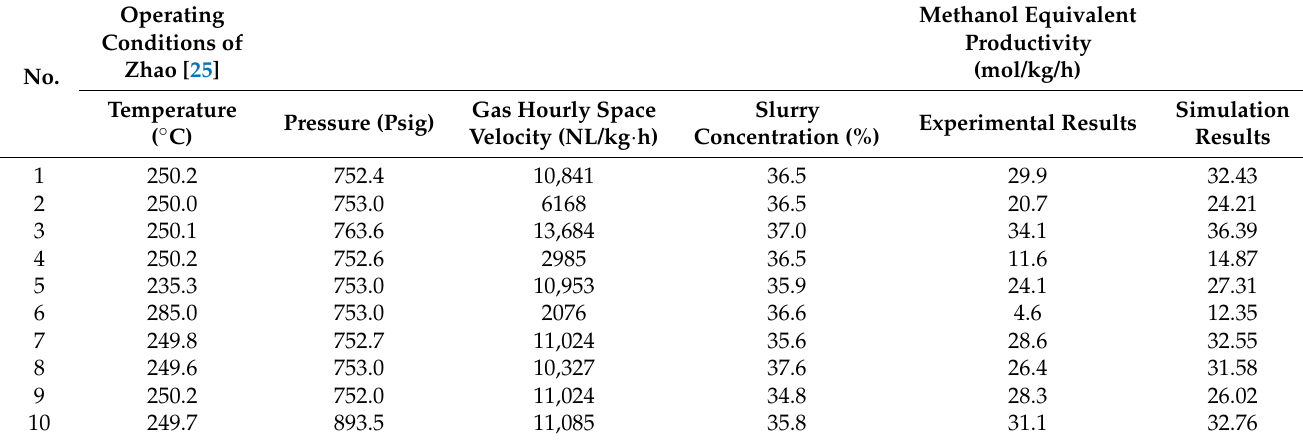
Table 3. Comparison of simulation results of methanol synthesis model with